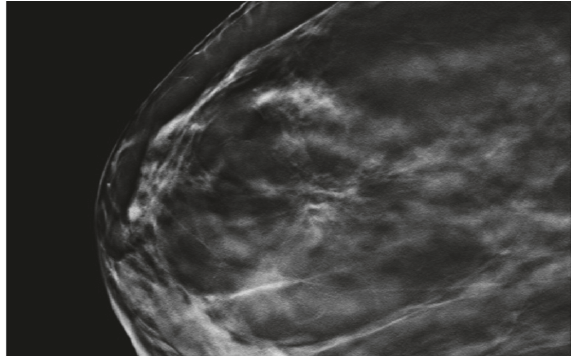
Figure 3: 72-year-old woman presenting for a screening mammog- raphy. Cropped image from a tomosynthesis view of the right breast in mediolateral oblique position showing an area of architectural distortion. The biopsy revealed stromal fibrosis. Surgical excision was performed and the final surgical pathology also confirmed stromal fibrosis.